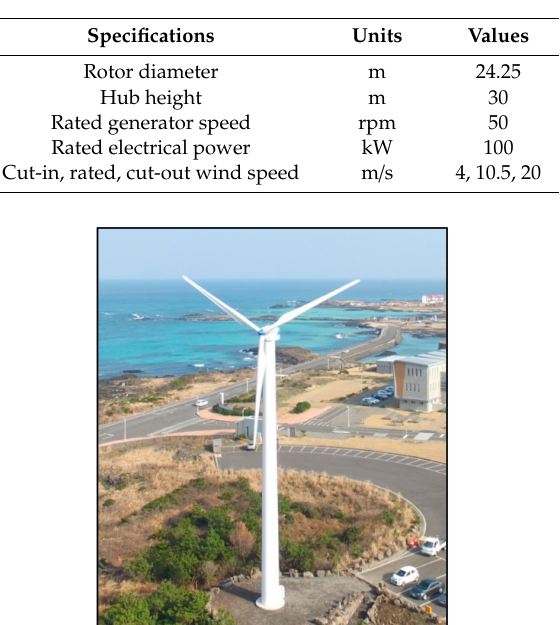
Figure 1. Image of the target wind